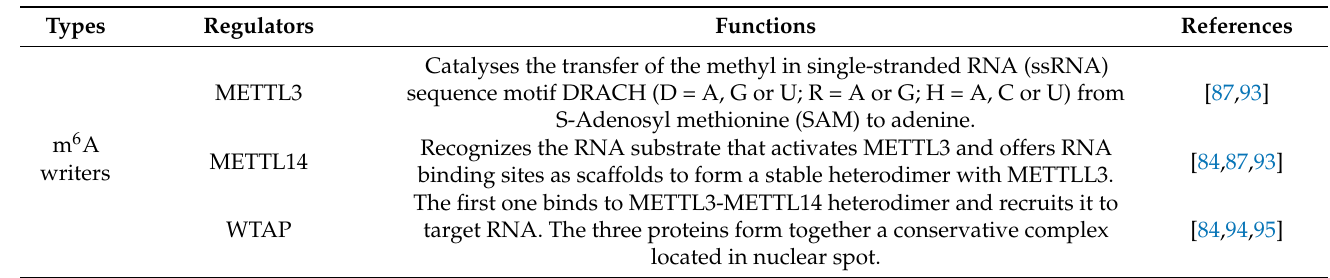
Figure 4. The expressions of cleaved caspase3 in colonic tissue of YTHDF1-knockout mice is significantly downregulated after TBI compared to WT mouses. * p < 0.05. Table 1. M 6 A related genes and their basic